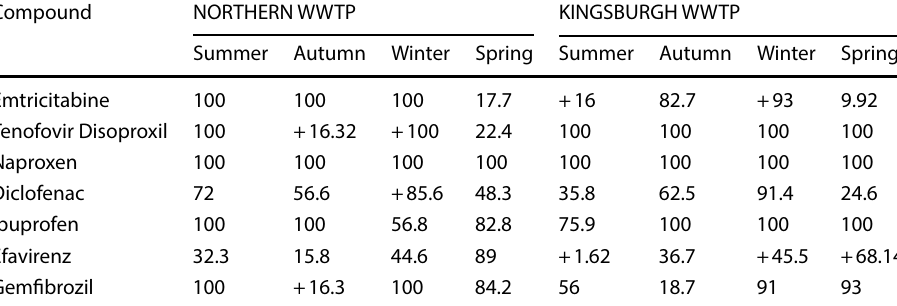
Table 4 Percent removal efficiencies for wastewater treatment plant